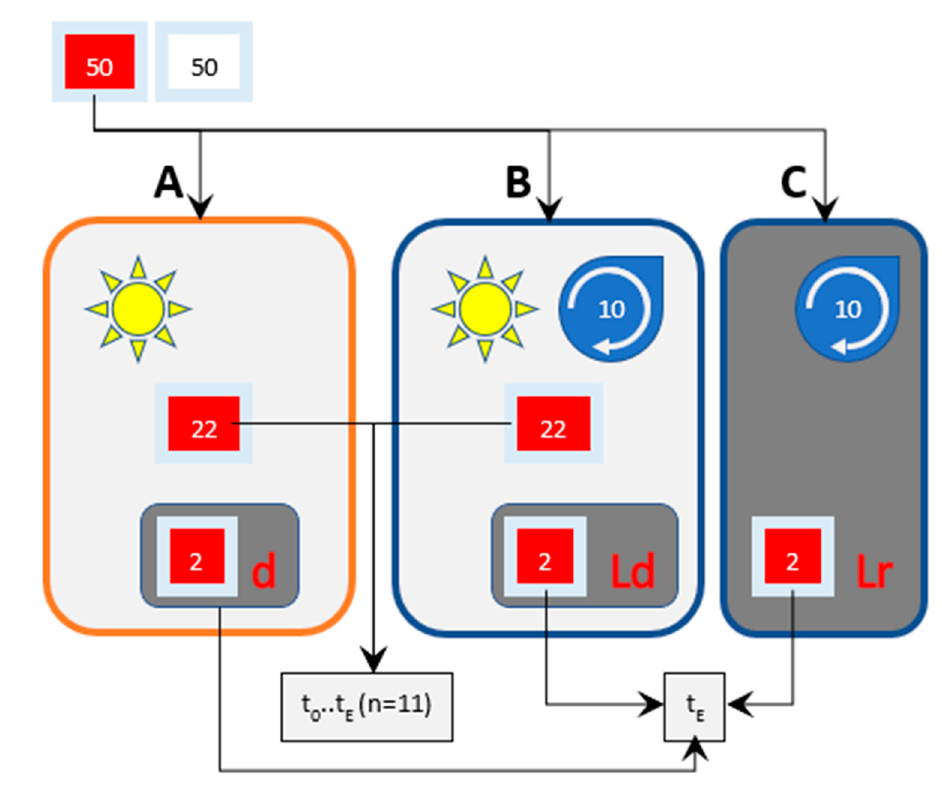
Figure 1. Illustration of exposure schemes (scheme only shown for red paint samples, white paint samples analog).